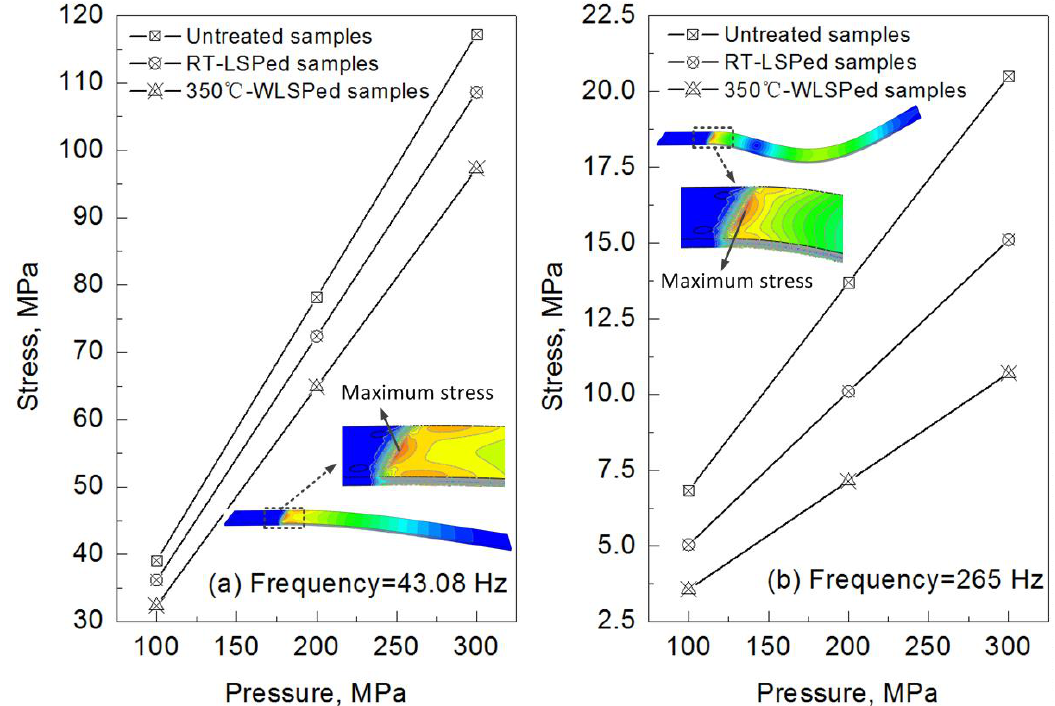
Figure 11. Vibration stress as a function of loaded pressure. ( a ) Frequency = 43.08 Hz, ( b ) Frequency = 265 Hz.